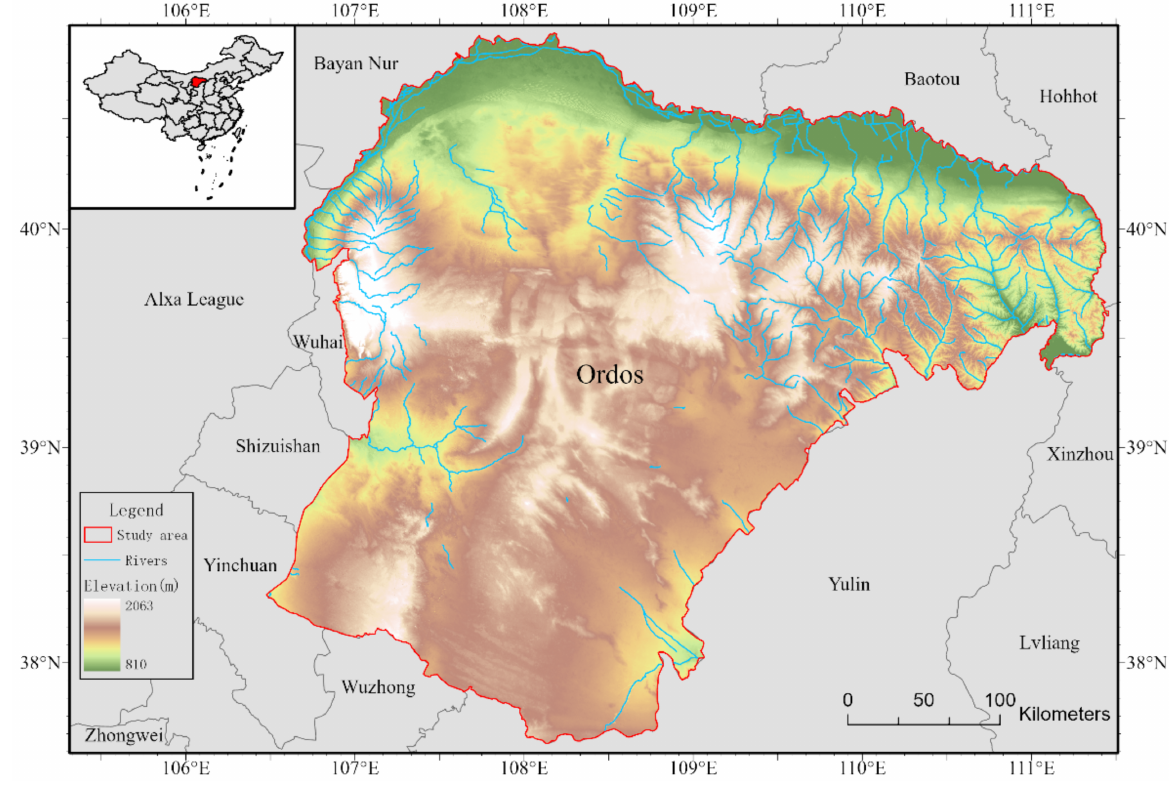
Figure 1. Overview of the study area.